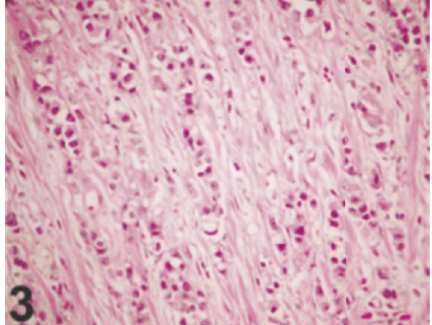
Figure 4: von Brunn nests in comparison with nested variant of urothelial carcinoma showing regularly spaced urothelial nests with a relatively flat base (hematoxylin-eosin, original magnification × 200). Nested variant of urothelial carcinoma taken from Dhall et al. [2]. The figures have been reproduced with the permission of the editor in chief of Archives of Pathology and Laboratory Medicine on behalf of the editorial board of the journal.